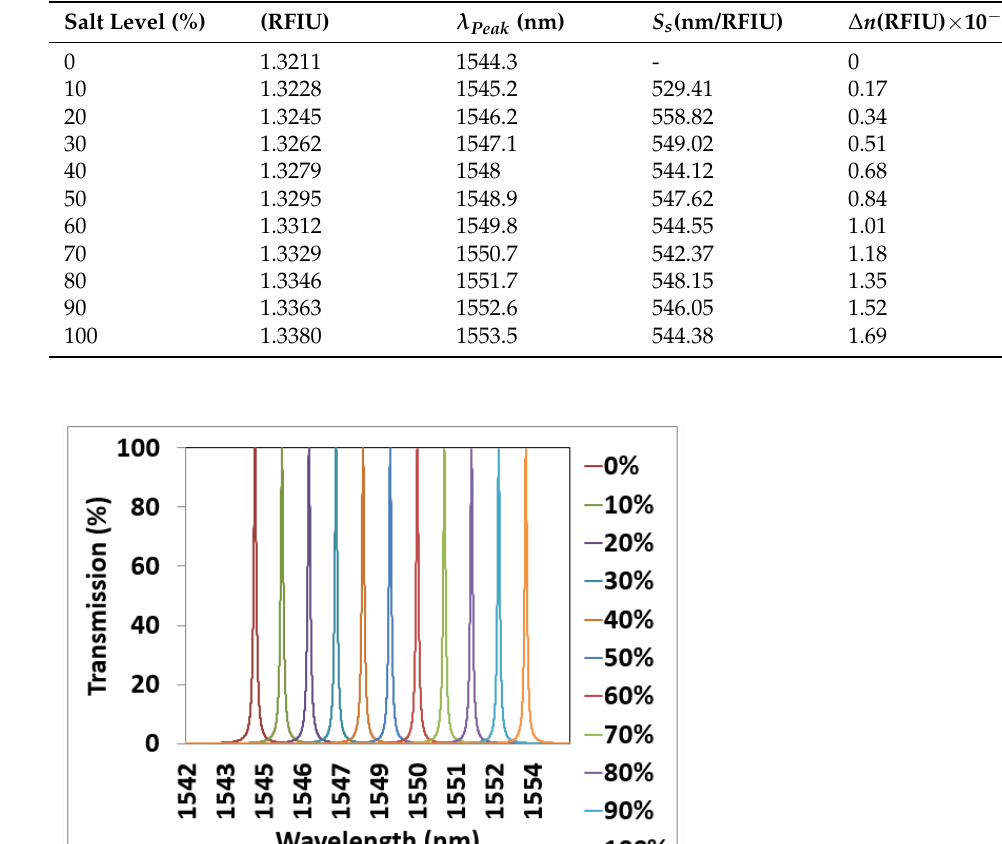
Table 2. Variation of the RFIU, λ peak and S s as Function of Salt Level.